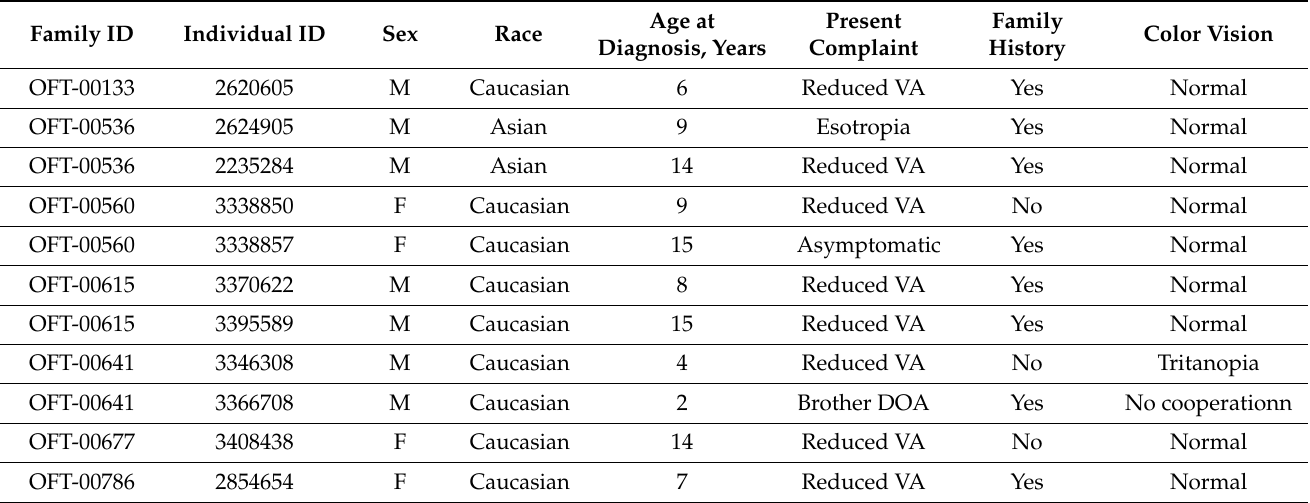
Table 1. Demographic characteristics of our